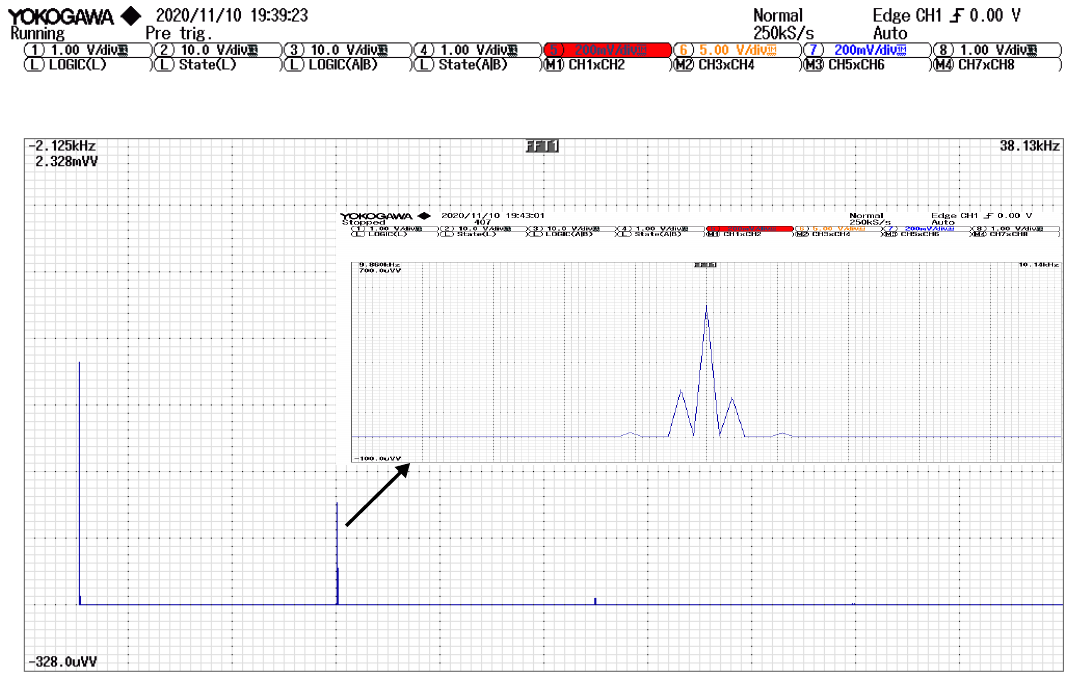
Figure 20. Experimental harmonic spectrum of phase voltage for the 9-level